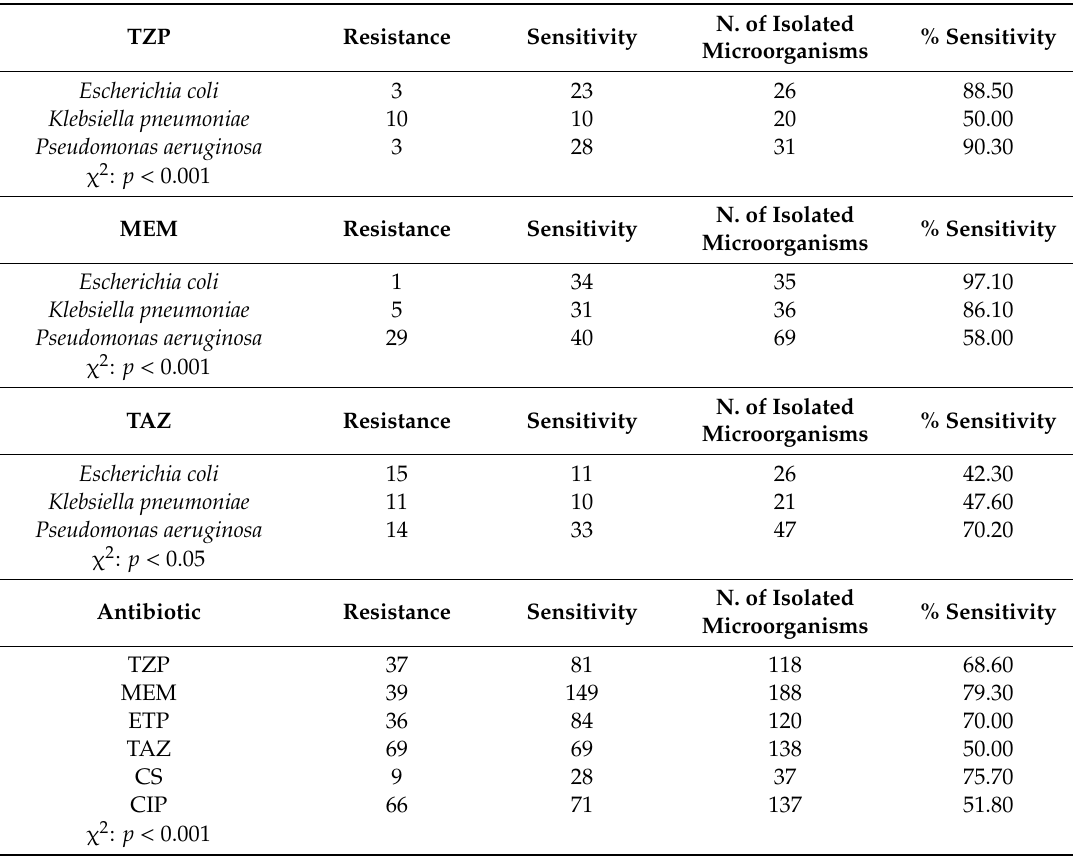
Table A2. Patients treated with ceftolozane / tazobactam: profile of the sensitivity and resistance of microorganisms versus di ff erent types of antibiotics.